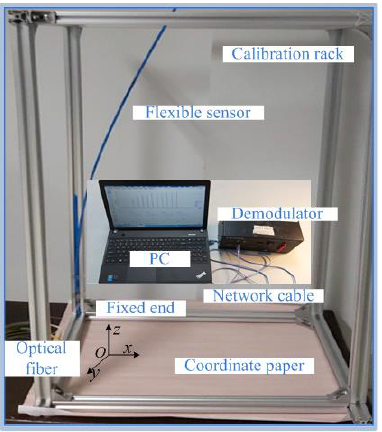
Figure 15. Diagram of deformation-sensing experimental device .